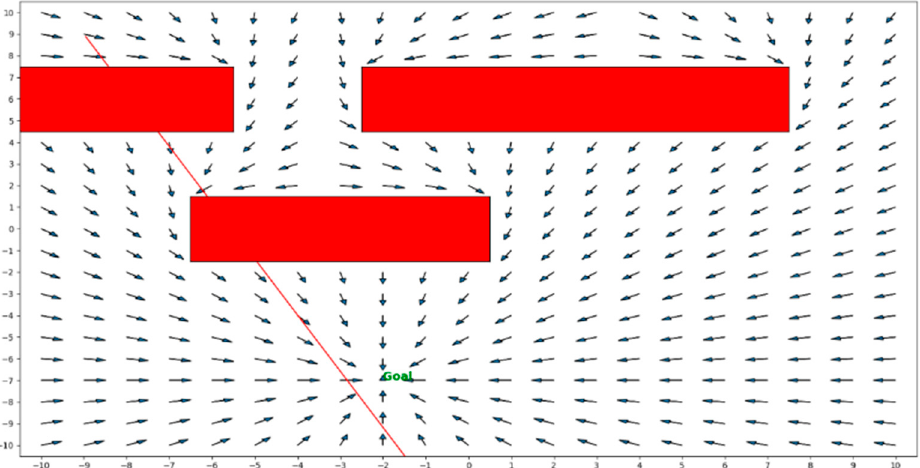
Figure 17. Collision with obstacles (red trajectory) with the conventional DDPG learning algorithm, even with the same training experience